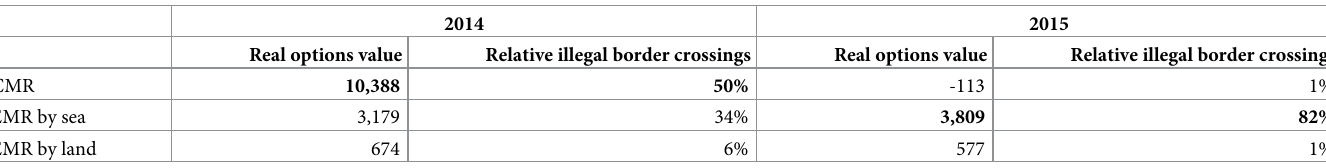
Table 4. Real options values of three main routes and relative amount of illegal border